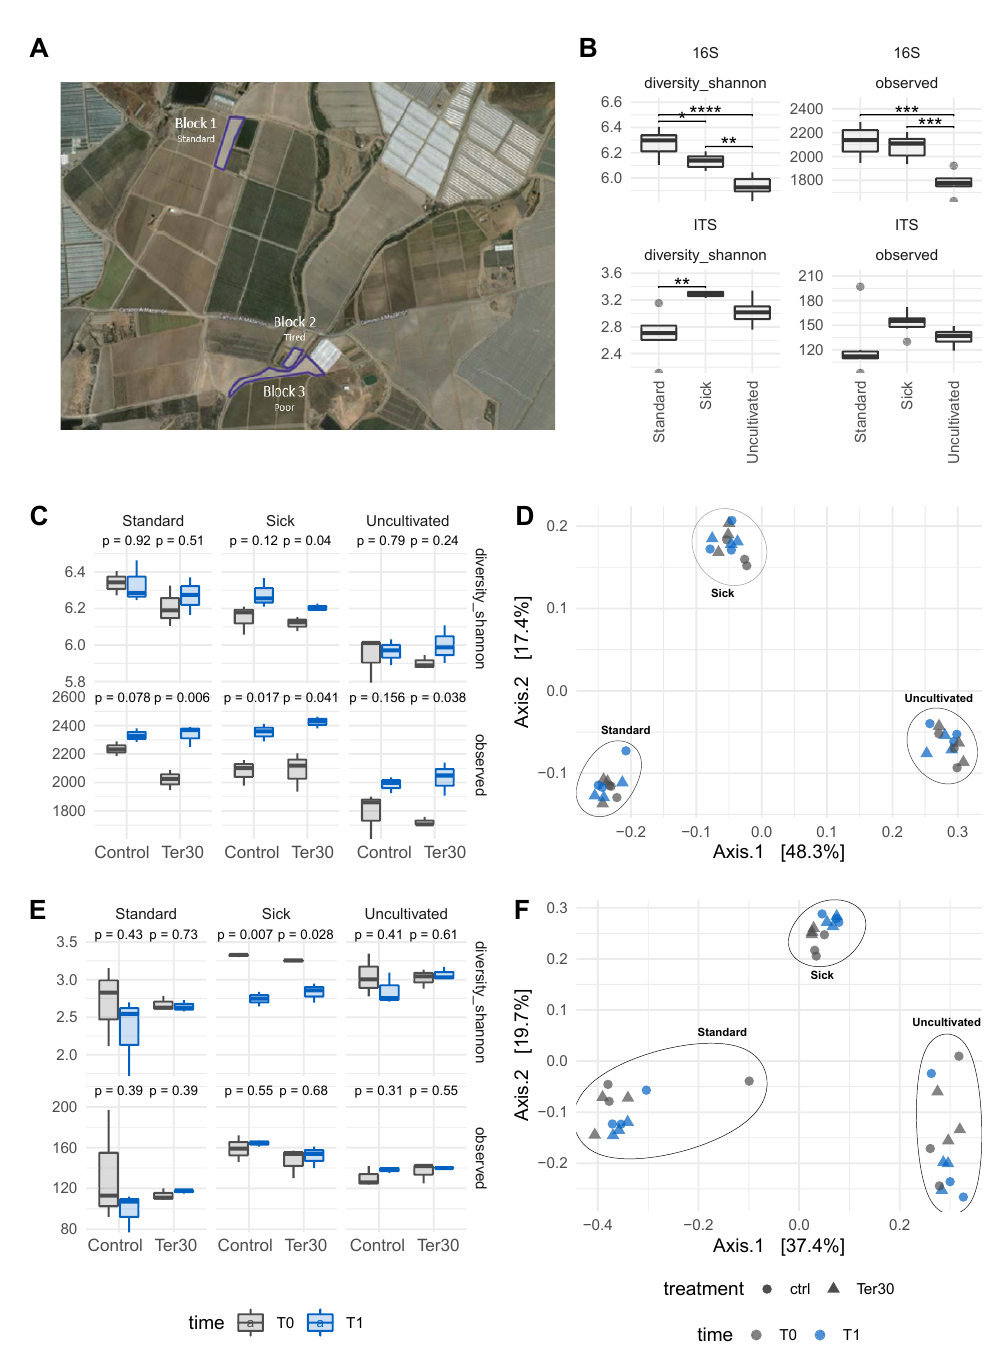
Figure 2. Geospatial distribution of field block 1, 2, and 3 corresponding to standard, sick, and un- cultivated soil types, respectively ( A ). Alpha diversity determined with Shannon index and number of observed taxa among soil types at T0 before treatment ( B ), after treatment with Terramin R (cid:13) Pro at 30 L ha − 1 , and control condition (T1) compared to before the treatment (T0) on bacteria and archaea ( C ) and fungi microbiota ( E ). p -values represent the resulting pairwise statistical significance level between a given condition at T1 compared to T0. Principal Coordinate Analysis (PCoA) using Bray–Curtis dis- tances of bacteria and archaea ( D ) and fungi microbiota ( F ) before (T0) and after the treatment (T1) on Terramin R (cid:13) Pro at 30 L ha − 1 and control conditions. Significant statistical differences between groups ( A , B ) or pairwise ( B ) are indicated as follows: * ( p -value < 0.05), ** ( p -value < 0.005), *** ( p -value < 0.0005), **** ( p -value <